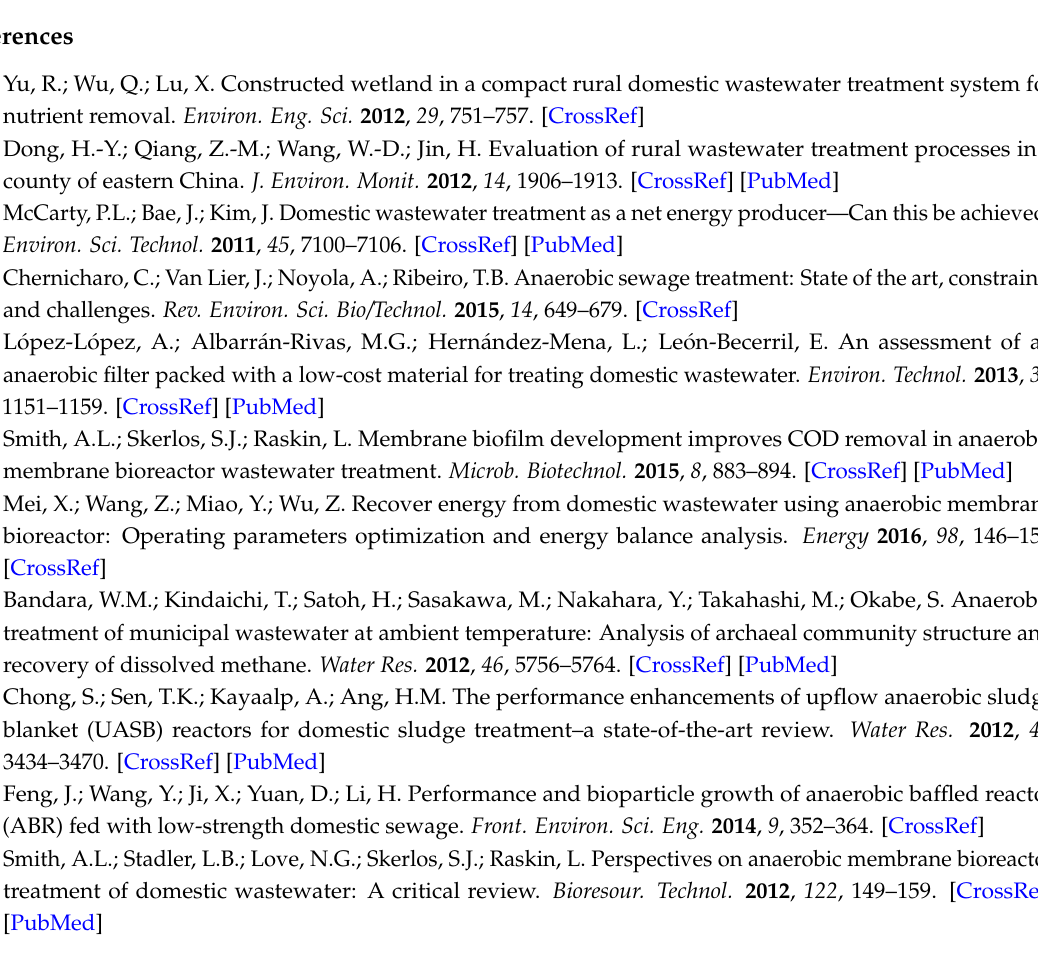
Table S1: The relative abundance of bacterial community at phylum